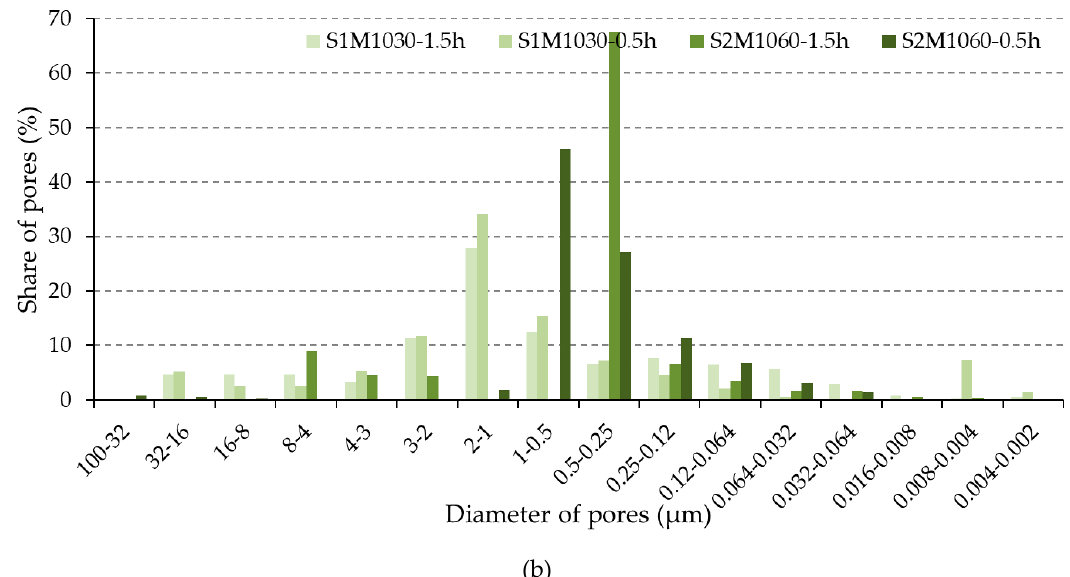
Figure 6. Pore-size distribution in the ( a ) hand-made and ( b ) machine-made fired bricks.